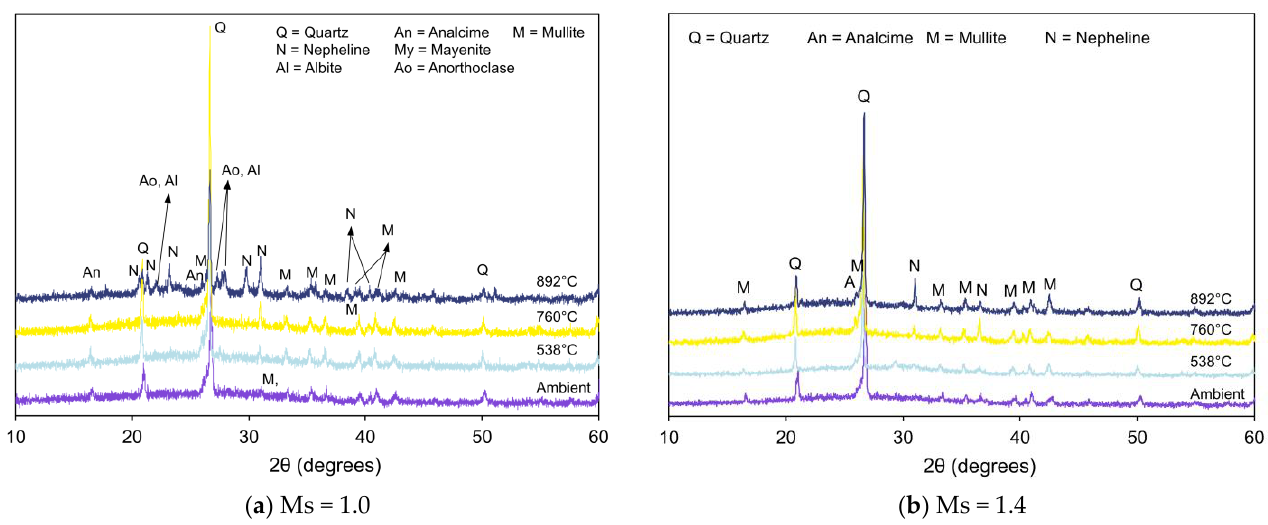
Figure 5. XRD pattern of FS 0P on exposure to elevated temperature.